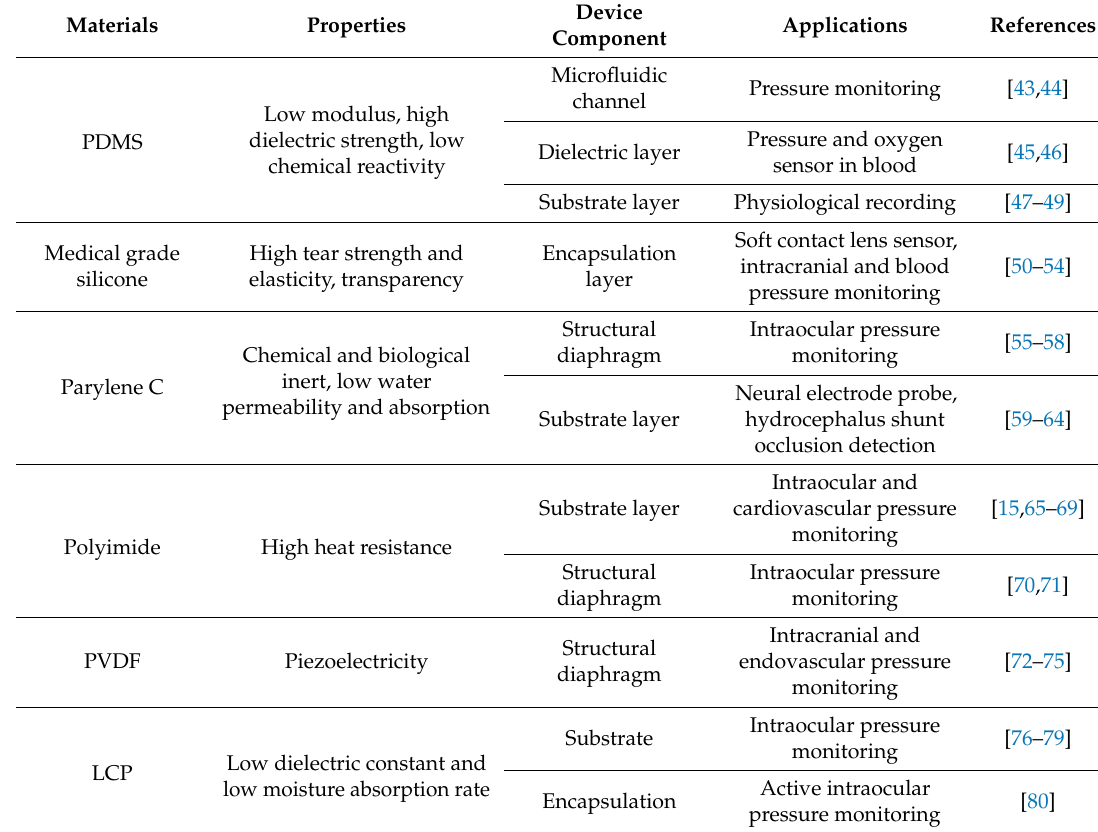
Table 2. Summaryoforganicmaterialswithapplicationsinbiomedicaldevices. PDMS:polydimethylsiloxane; PVDF: polyvinylidene fluoride; LCP: liquid crystal